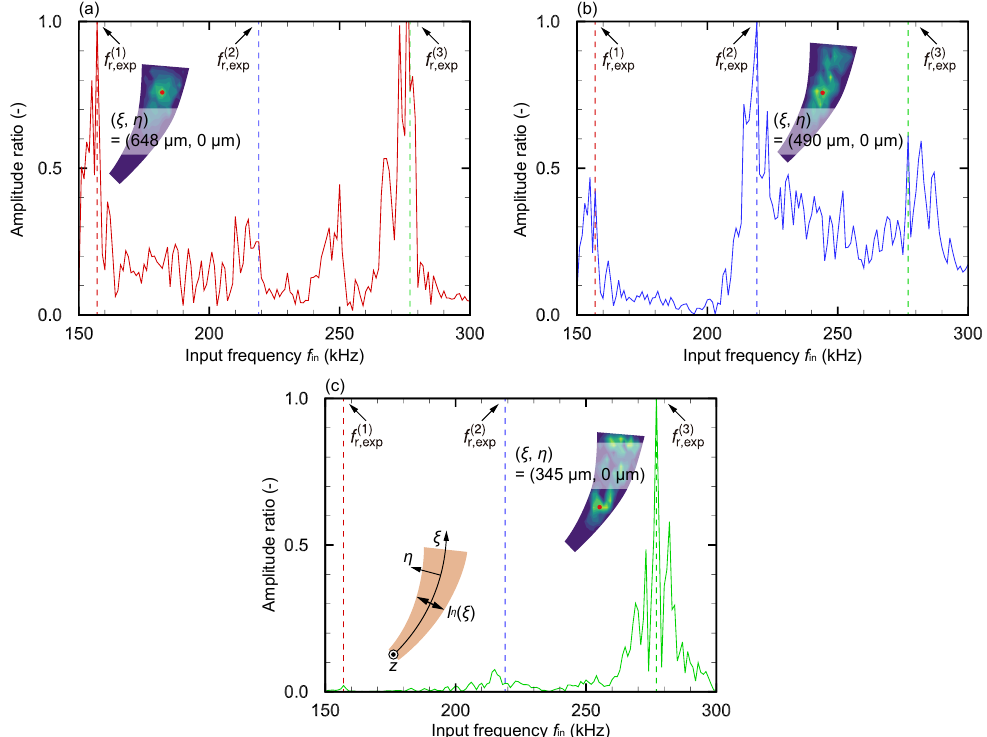
Figure 10. Experimentally obtained resonance characteristics of the miniaturized artificial cochlear sensory epithelium at ( a ) ( ξ , η ) = (648 µ m, 0 µ m), ( b ) ( ξ , η ) = (490 µ m, 0 µ m), and ( c ) ( ξ , η ) = (345 µ m, 0 µ m). The red dots indicate the measurement points defined by the curvilinear coordinates. Several frequencies are observed where the amplitude is maximized, and these frequencies are defined as the resonance frequency based on the experimental results. Therefore, each measurement position has the local resonance frequency, and it is demonstrated that the miniaturized device reflects the frequency selectivity